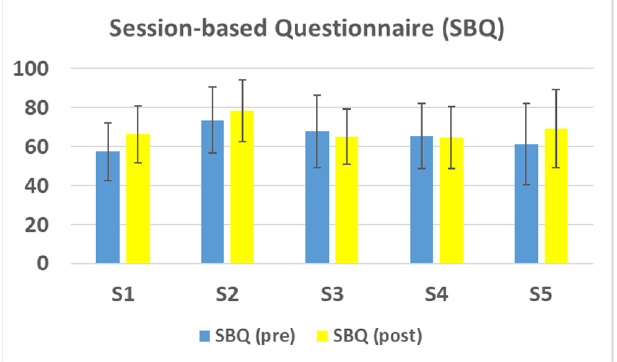
Figure 15. SBQ (pre/post).